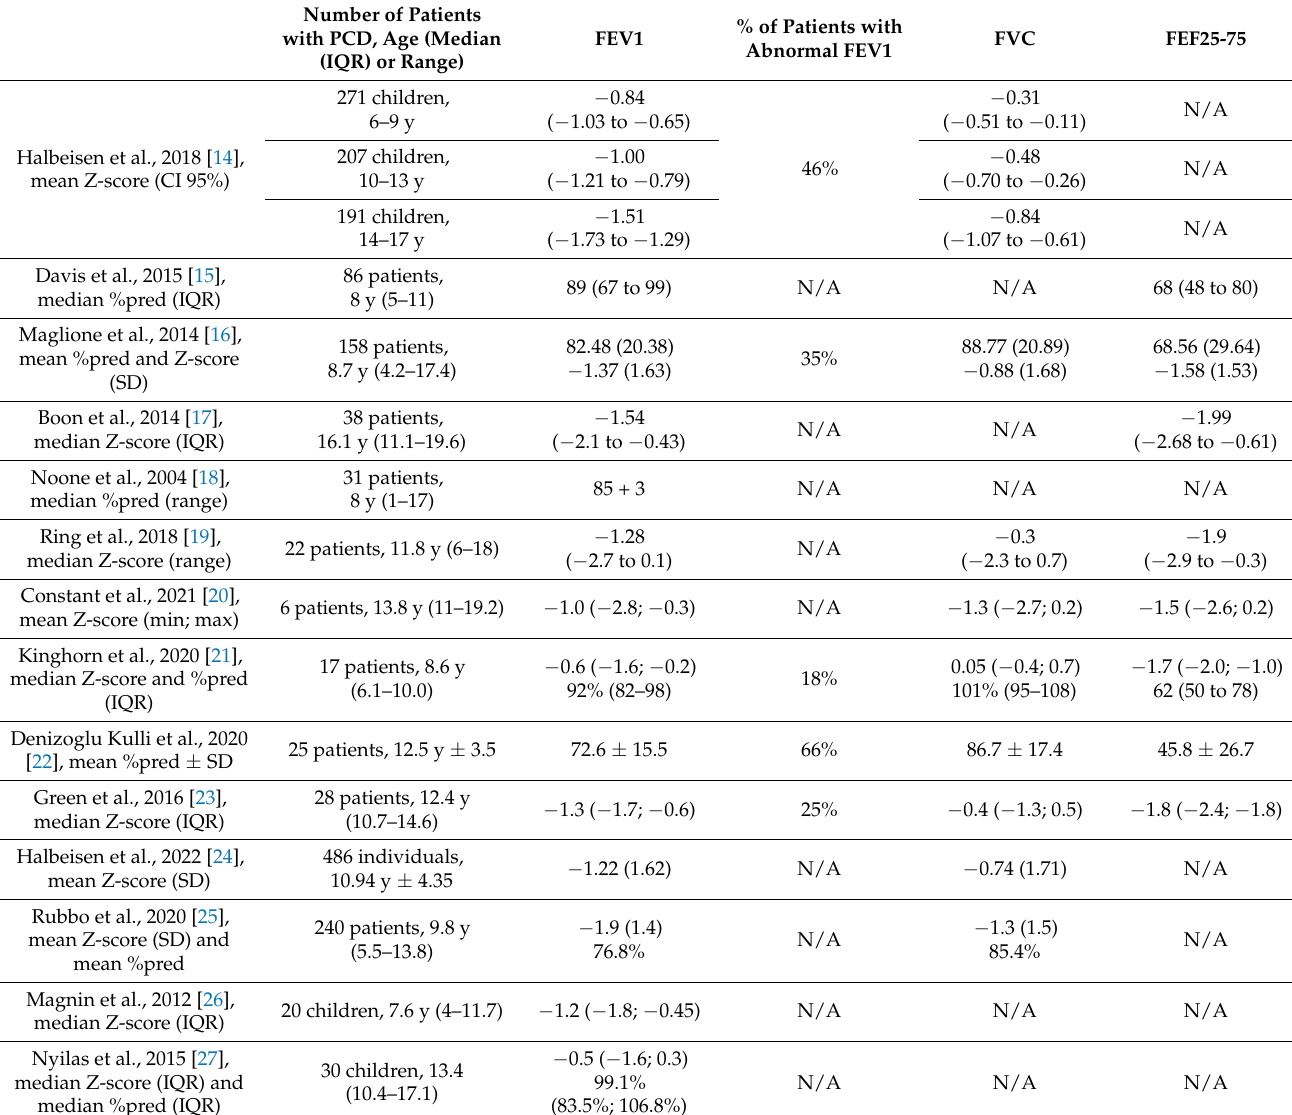
Table 1. Spirometric values in children with PCD. N/A = not